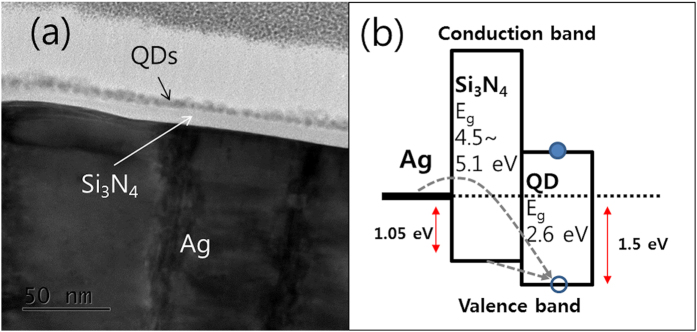
(a) TEM image representing a QD monolayer, 20-nm thick Si3N4 and 300-nm thick Ag films. (b) Energy level diagram of QDs, Si3N4 and Ag films.